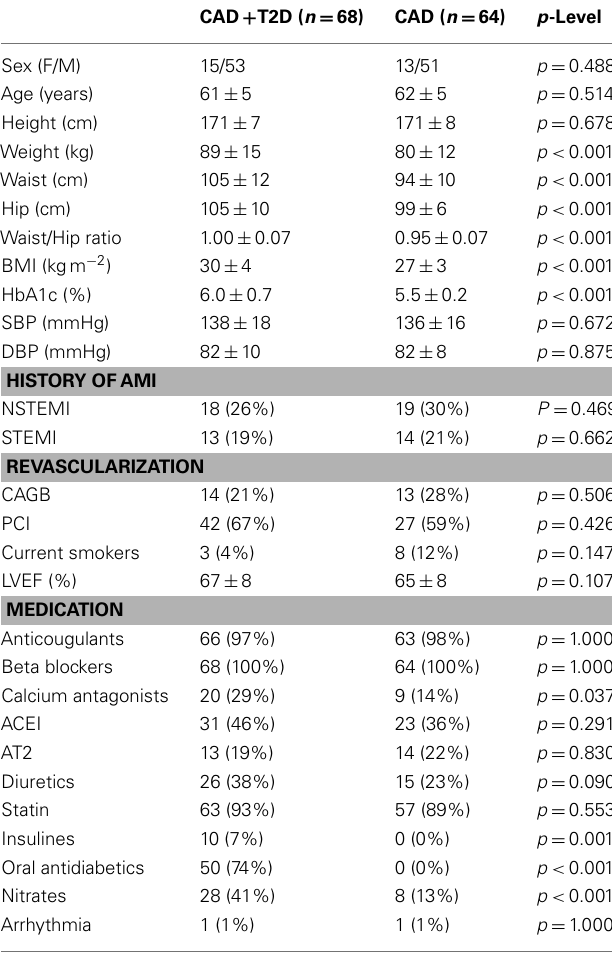
Table 1 | Characteristics of